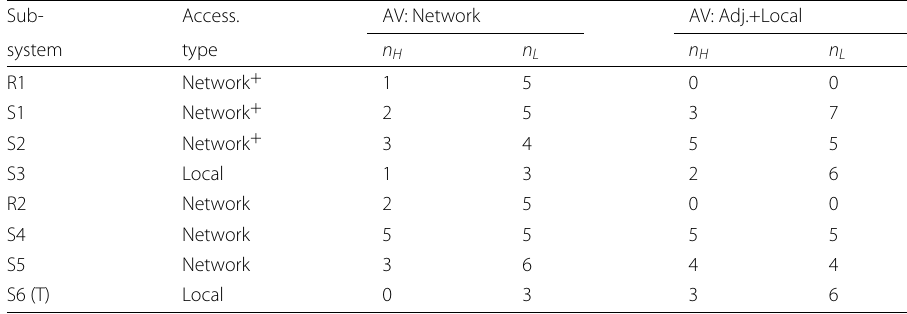
Table 2 The shared system state SQ Sub-